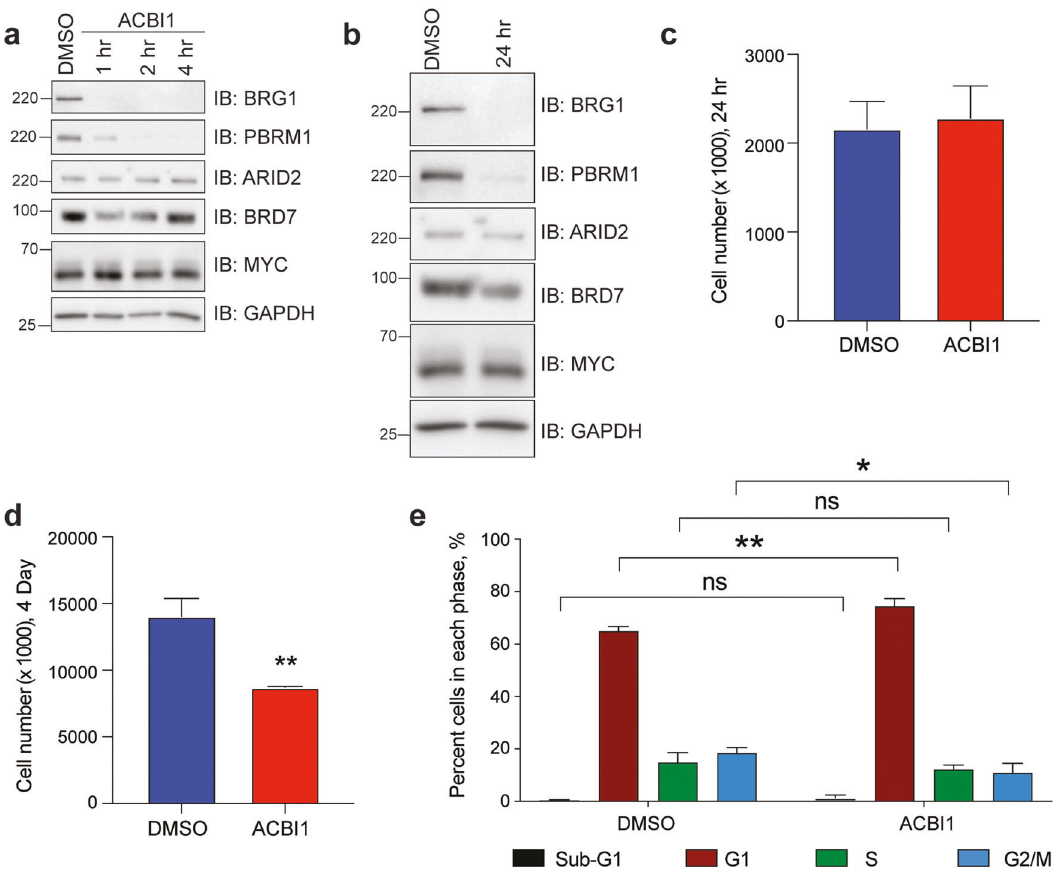
Fig. 1 ACBI1 depletes SWI/SNF subunits BRG1 and PBRM1. a G401 cells were treated with 250 nM ACBI1 for the indicated times and protein lysates were probed for expression of BRG1, pBAF-speci fi c subunits PBRM1, ARID2, and BRD7, and MYC. DMSO control is matched to longest treatment. GAPDH is used as a loading control. b G401 cells were treated as in a for 24 h and protein lysates probed for the indicated proteins. GAPDH is used as a loading control. c G401 cells were plated with 250 nM ACBI1 or DMSO control and cell growth monitored over 24 h ( n = 5 biological replicates, error bars are standard error). d G401 cells in c were allowed to grow for 4 days in the presence of ACBI1 or DMSO control and cells counted at this timepoint ( n = 5 biological replicates, error bars are standard error, ** P = 0.004 using unpaired t -test, two-tailed between DMSO and ACBI1). e Cell cycle analysis of G401 cells treated with 250 nM ACBI1 or DMSO control for 4 days as determined by fl ow cytometry ( n = 4 biological replicates, error bars are standard error, ** P = 0.0015, * P = 0.0117 using unpaired t -test,